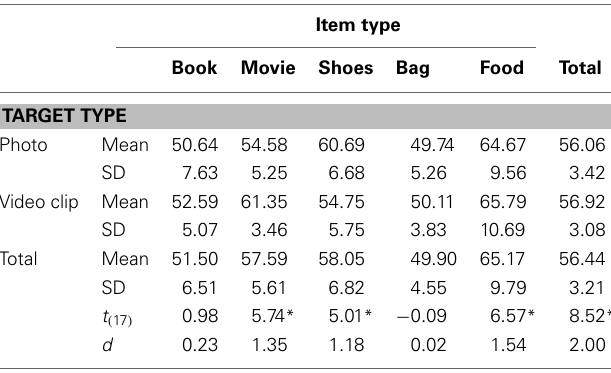
Table 1 | The descriptive statistics of all conditions in the pretest and the results of the one-sample t